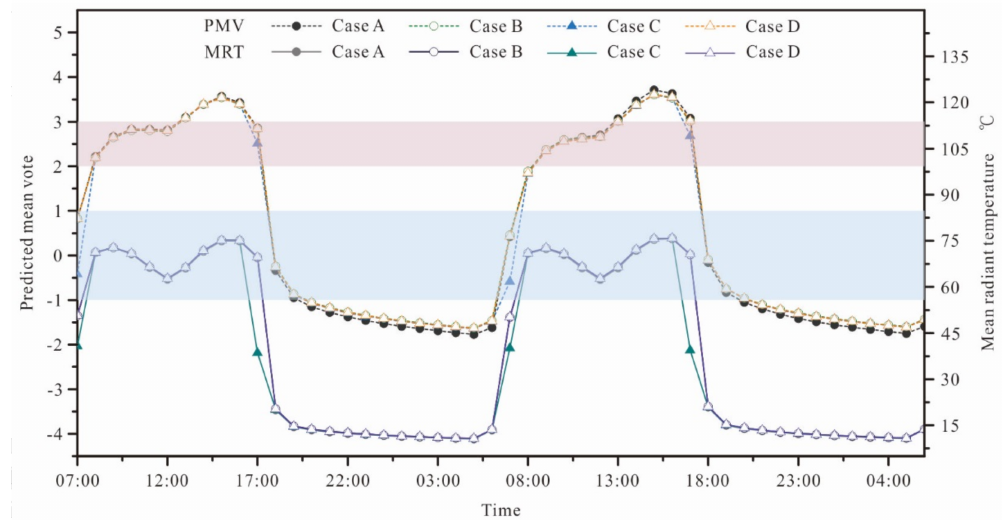
Figure 12. Temporal profiles of mean radiant temperature (MRT) and predicted mean vote (PMV) at point P.